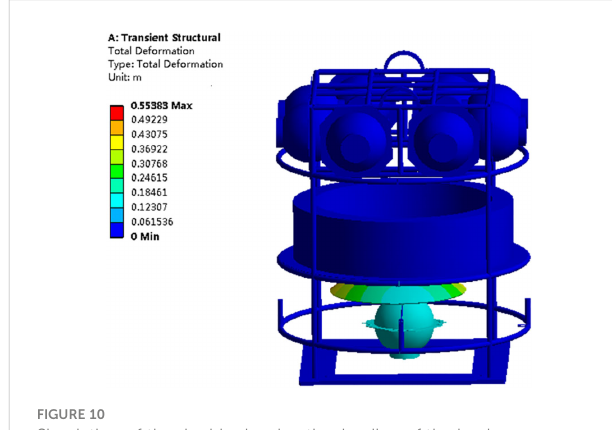
FIGURE 10 Simulation of the double decelerating landing of the